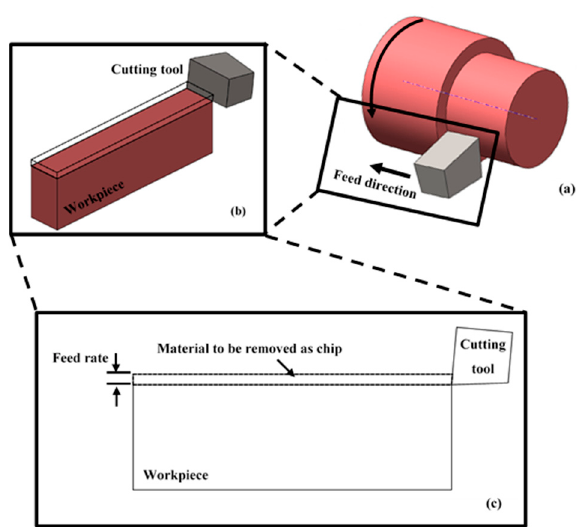
Figure 1. Modelling of turning process using Finite Element Method (FEM): ( a ) Turning process normal arrangement, 3D FE representation of the turning process ( b ) and ( c ) 2D FEM model of turning process where the tool remove a feed rate each stoke.